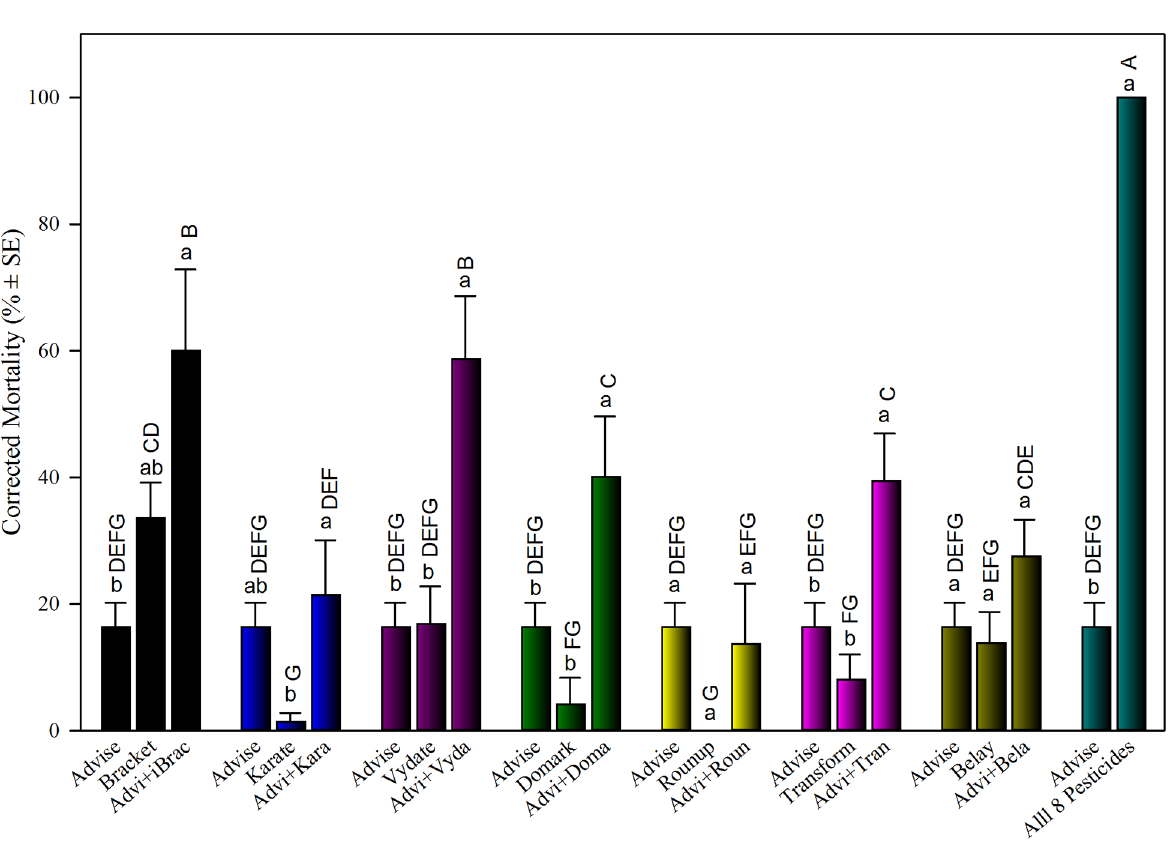
Fig 1. Acute toxicity of Advise (imidacloprid) and seven binary pesticide mixtures to honey bees. All concentrations used are listed in Table 1 as LC 20 determined in a previous study [30]. Advi, Brac, Kara, Vyda, Doma, Roun, Tran, and Bela were used as abbreviations for the same order of eight pesticideslisted in Table 1. Same letters above the error bars indicateno significantdifference: lower case letters are for within-group comparisons; capital letters refer to comparisons amongall treatments. The corrected mortality from Advise only was reusedin each group for within-group comparisonand